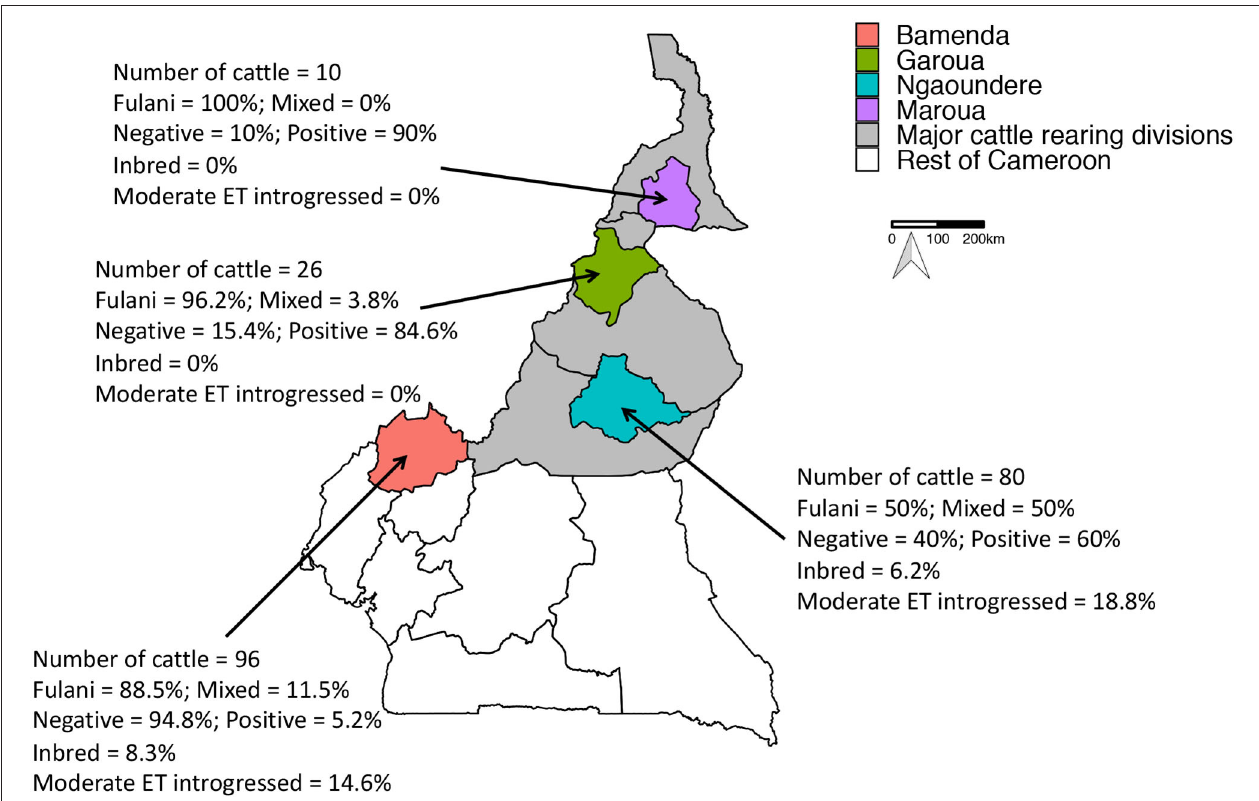
FIGURE 1 | Map of Cameroon showing the major cattle rearing divisions and the divisions where the abattoirs are located. The number of genotyped cattle per abattoir, the proportion of mixed and Fulani cattle, proportion of M. bovis positive cattle, proportion of inbred cattle and proportion moderately European taurine introgressed cattle per abattoir is also